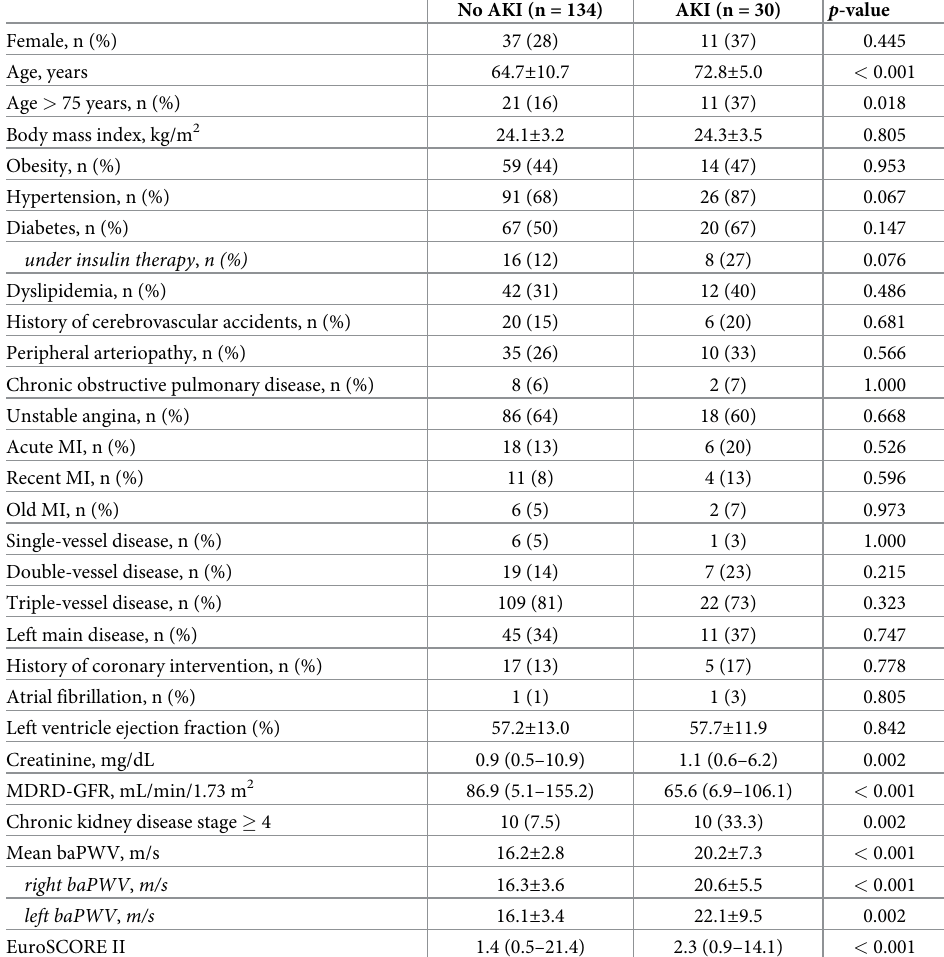
Table 1. Baseline characteristics of patients with and without postoperative